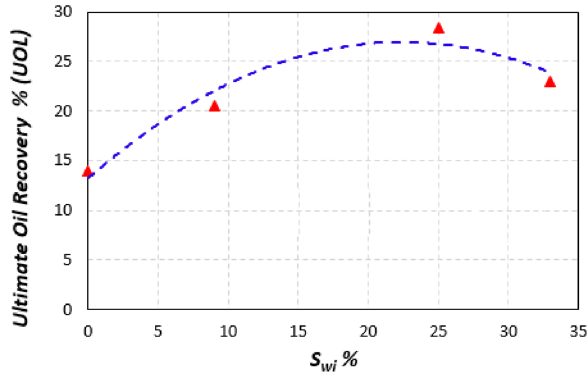
Fig. 3 Ultimate oil recovery versus initial water saturation resulted from imbibition tests on carbonate rocks (test #1 to 4)